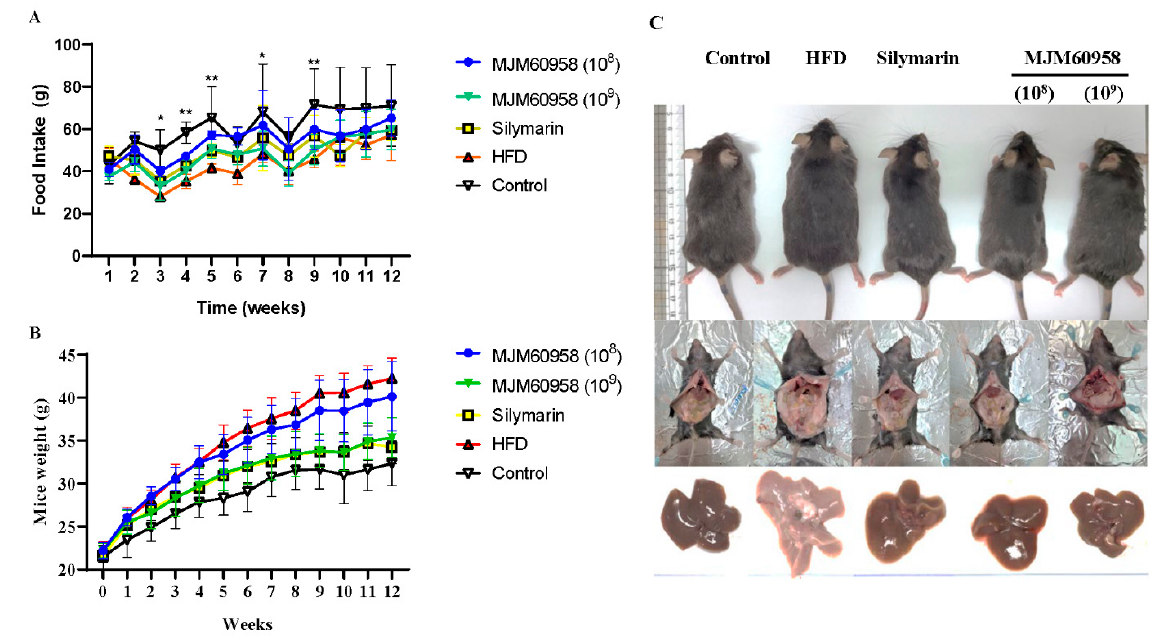
Figure 2. Food intake, body weight during 12 weeks, and mice images at the end of week 12. ( A ) Food intake and ( B ) body weights were measured every week. ( C ) Mouse and liver images after 12 weeks of treatment. Data were analyzed by two-way ANOVA ( n = 8 mice per group). * p < 0.05, ** p < 0.01 compared with HFD. Table 5. Effect of L. sakei MJM60958 on body weight and organs ( n = 8) after 12 weeks of treatment.